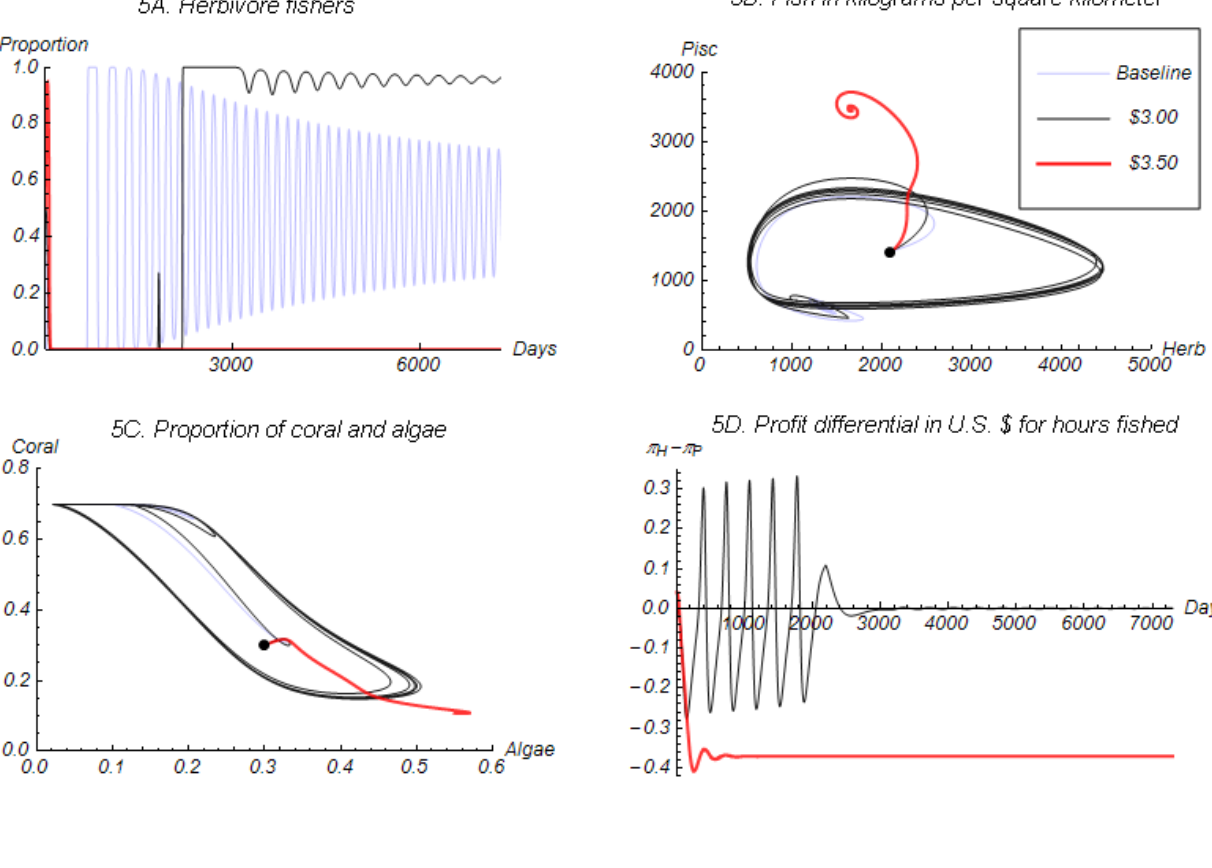
Fig. 5 . Simulation results reflecting changes in the price of herbivorous fish showing time-series plots for fishers (5A) and profit differentials (5D), and parametric plots for fish (5B) and for coral and algae (5C). The dots represent initial